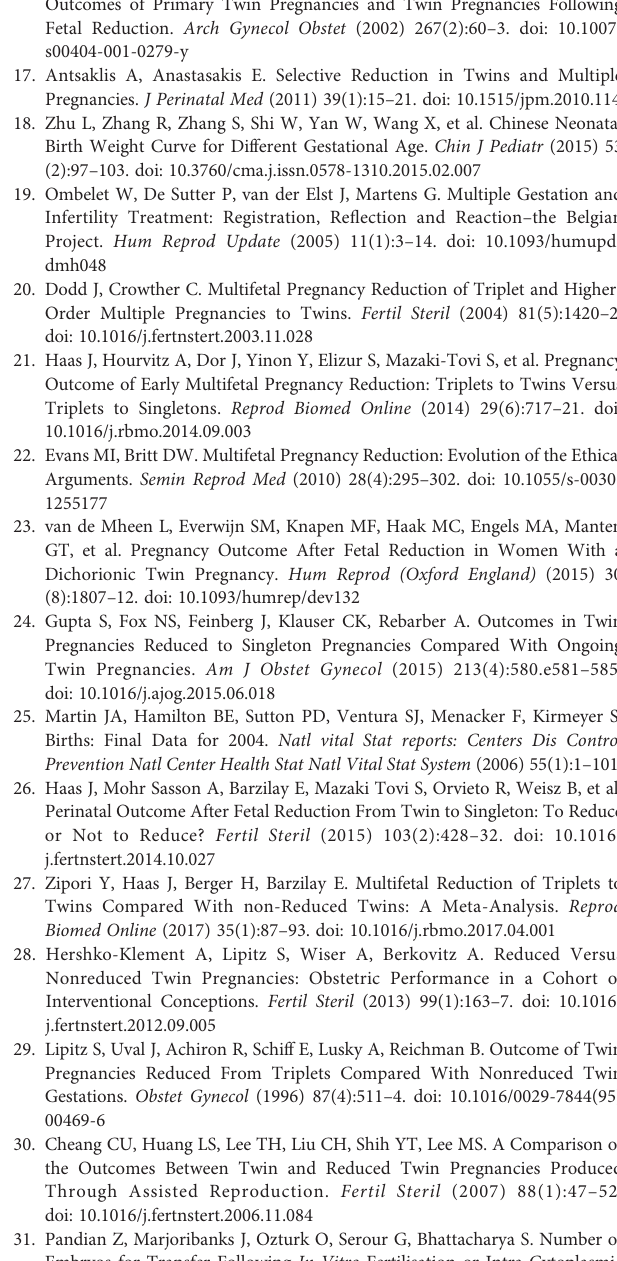
Supplementary Table 1 | Pregnancy outcomes: triplets or twins reduced to singletons versus primary singletons. Supplementary Figure 1 | The birth weight of newborns in different